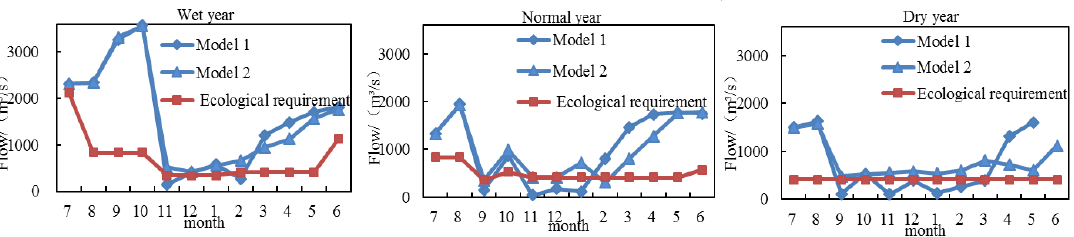
Figure 6. Water level change of the Xiaolangdi reservoir in each typical year.